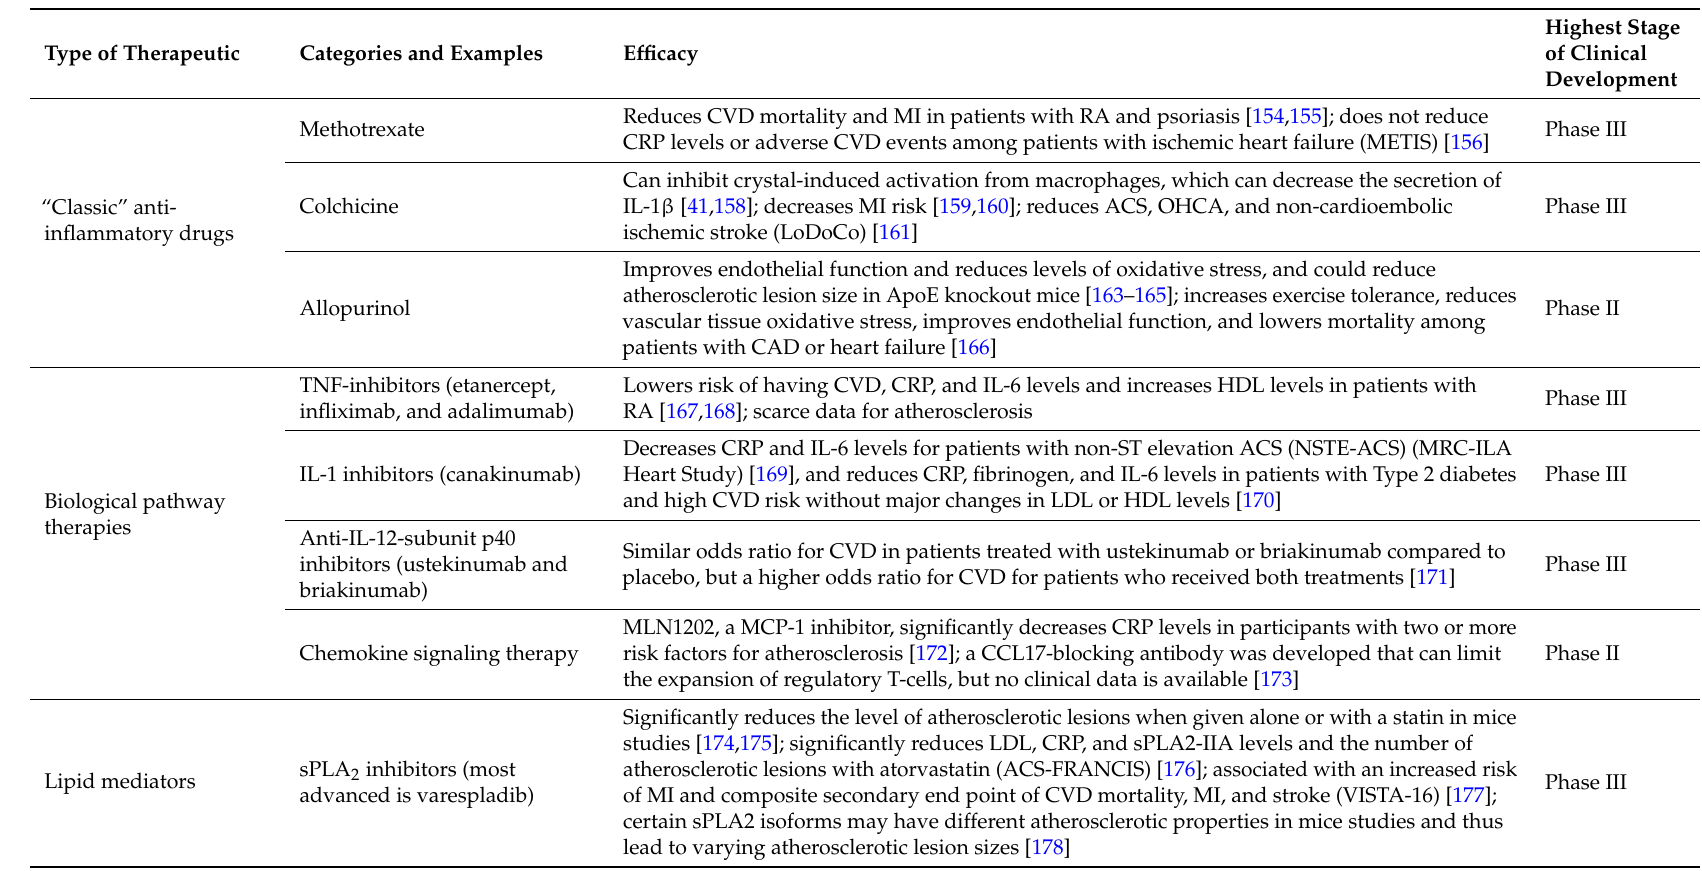
Table 1. Current Anti-Inflammatory Therapeutics for